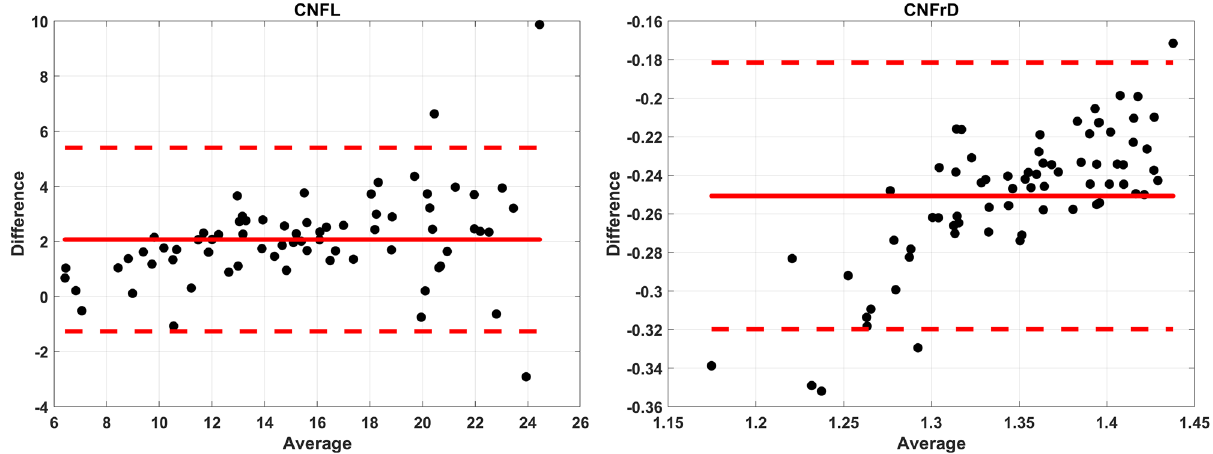
Figure 2. Bland–Altman (mean ± LOA) plots for ( A ) CNFL and ( B ) CNFrD as an indication of agreement between ACCMetrics and Voxeleron